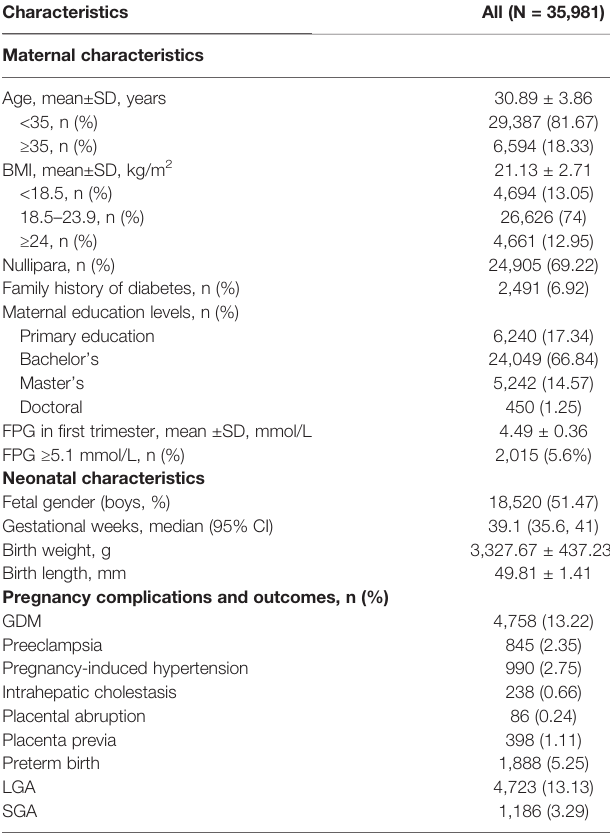
TABLE 1 | Baseline characteristics of study